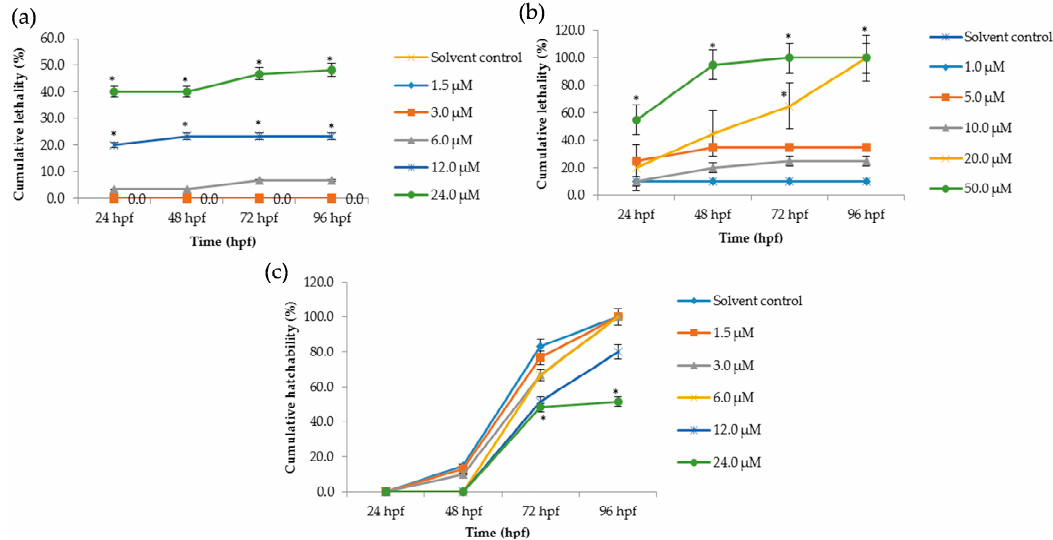
Figure 2. Cumulative lethality and hatchability curves of embryos exposed to different concentrations of Tan-IIA. ( a ) Cumulative lethality curves of chorionic embryos; ( b ) Cumulative lethality curves of dechorionated embryos; ( c ) Cumulative hatchability curves of chorionic embryos. ( n = 20 zebrafish per treatment; * p < 0.05, compared to control).